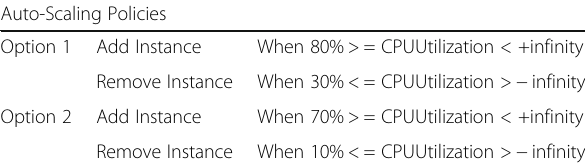
Table 6 Auto-Scaling polices Auto-Scaling